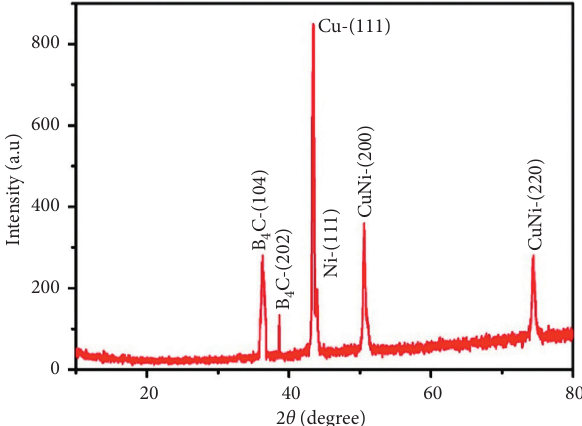
Figure 11: Optical micrograph showing interface zone between CuNi alloy substrate and CuNi/B 4 C surface composite